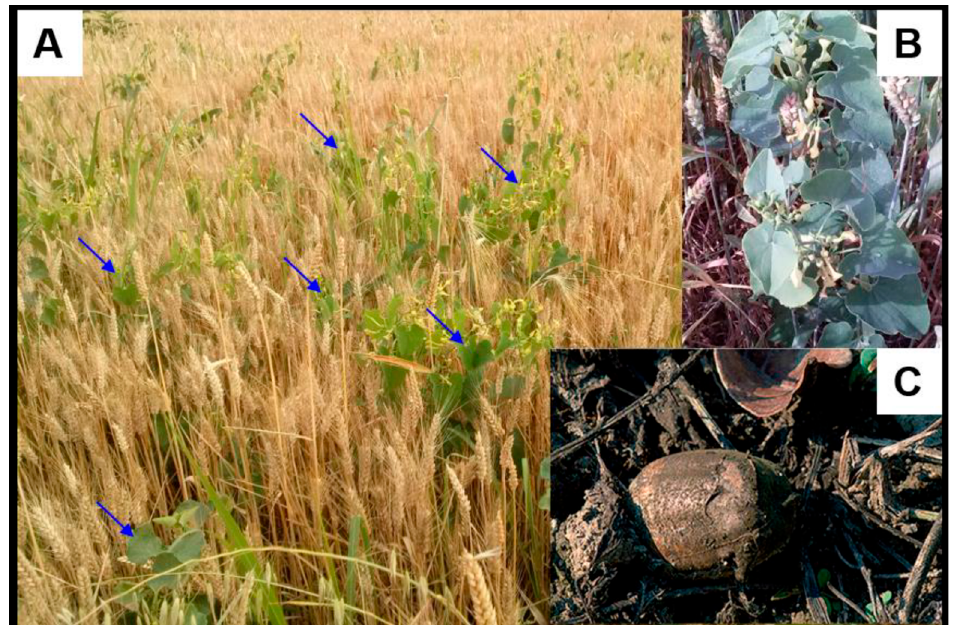
Figure 3. Photos showing ( A ) Aristolochia clematitis growing in a wheat field in the village Kutleš in Serbia (photo taken in May 2015), ( B ) enlarged view of Aristolochia clematitis growing together with wheat in cultivated field, and ( C ) decaying seed of Aristolochia clematitis in the wheat field.